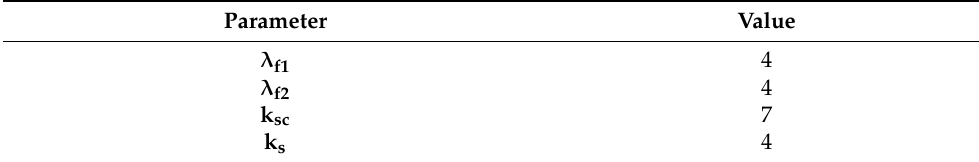
Table 6. Control parameters of the sliding mode control